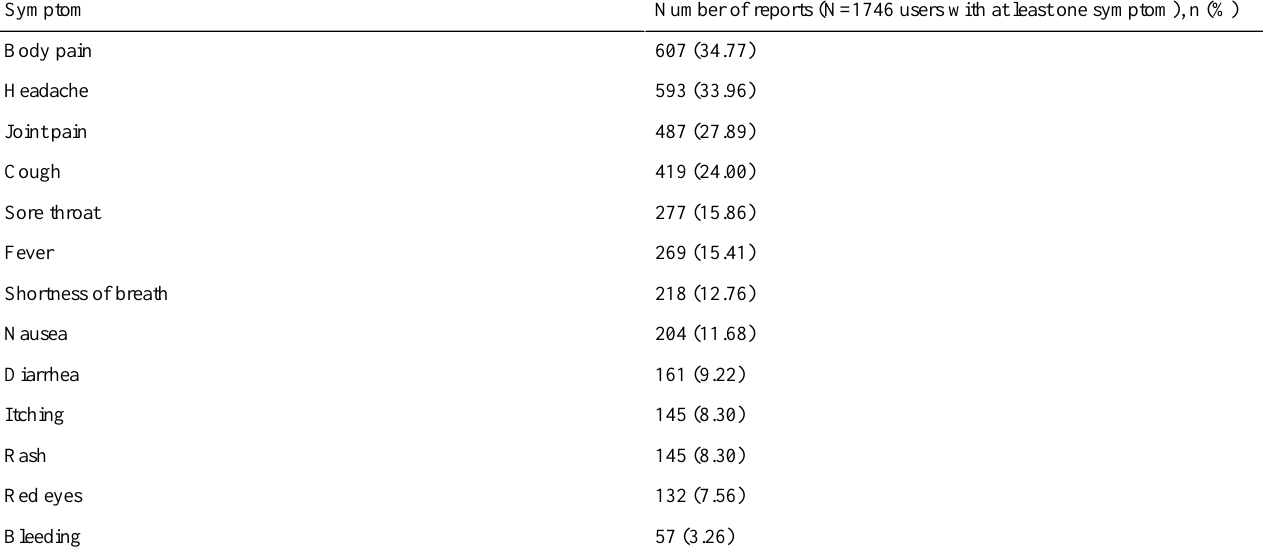
Table 2. List of symptoms reported via Guardians of Health during the Rio 2016 Olympic Games period.